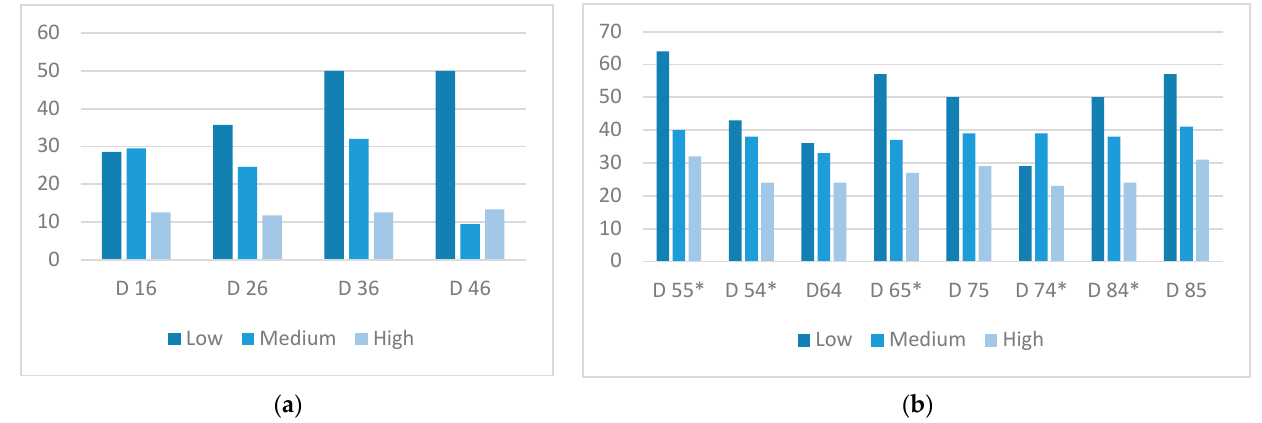
Figure 3. Caries prevalence of the most relevant teeth according to the level of adherence to the Mediterranean diet: ( a ) permanent dentition; ( b ) temporary dentition. * Statistically significant differences.